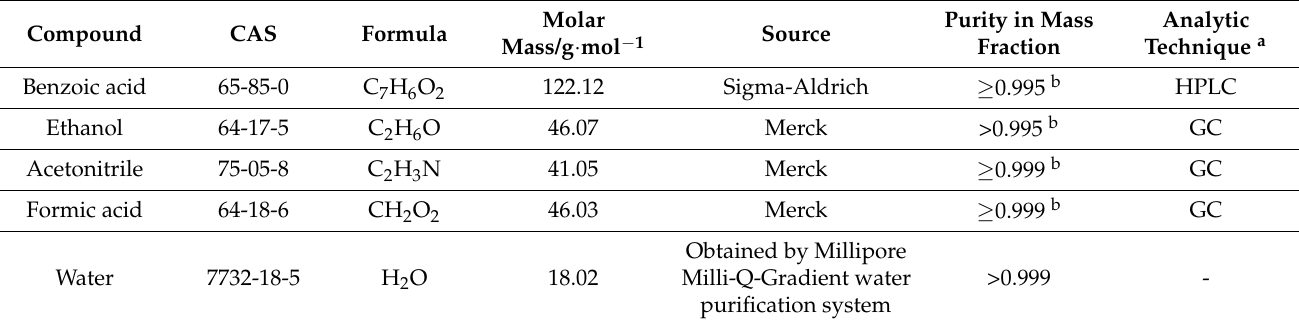
Table 1. Source and purities of the compounds used in this